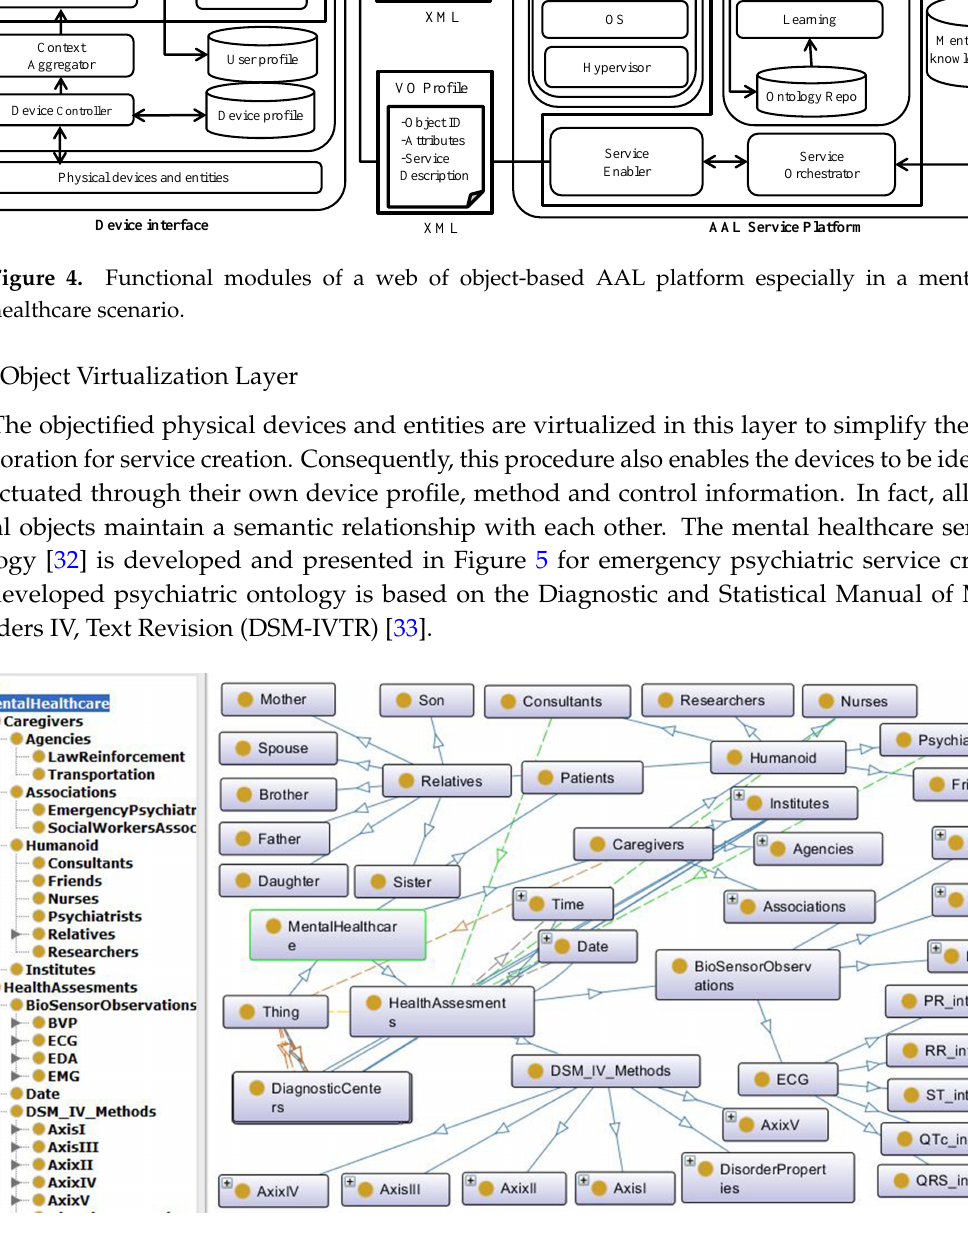
Figure 5. The mental healthcare semantic ontology for emergency psychiatry in an AAL